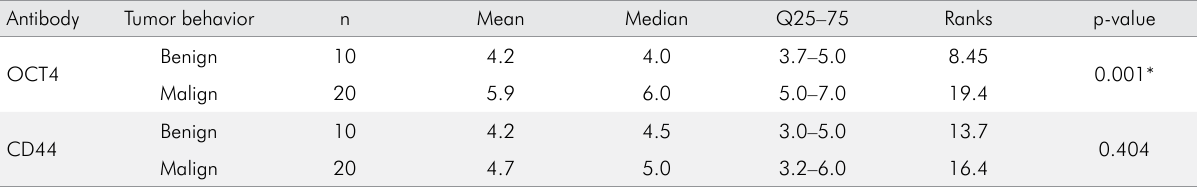
Table 3. Evaluation of OCT4 and CD44 immunoexpression according to lesion behavior in MiSGs.